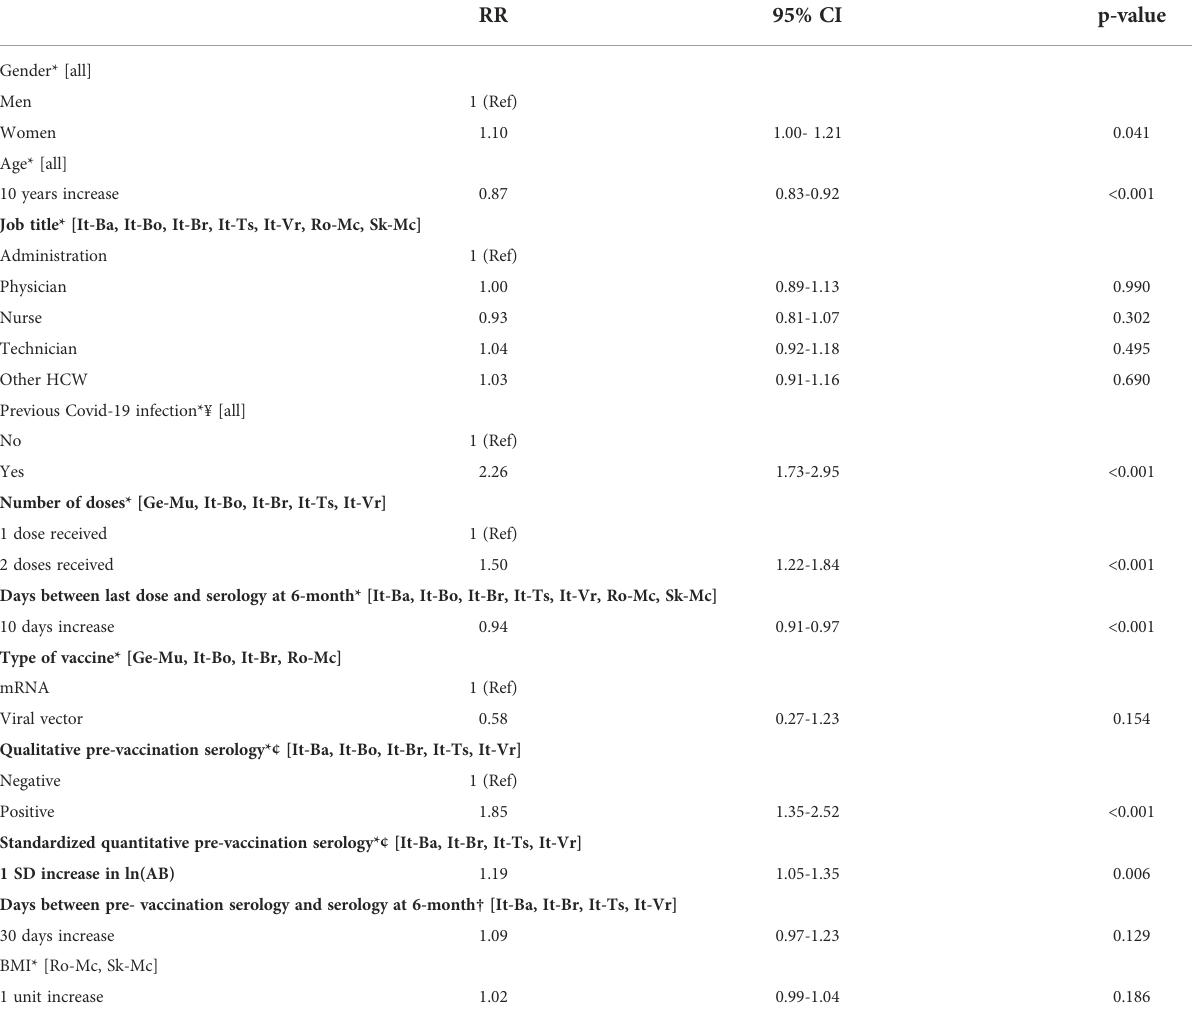
TABLE 3 Determinants of standardized antibody level at